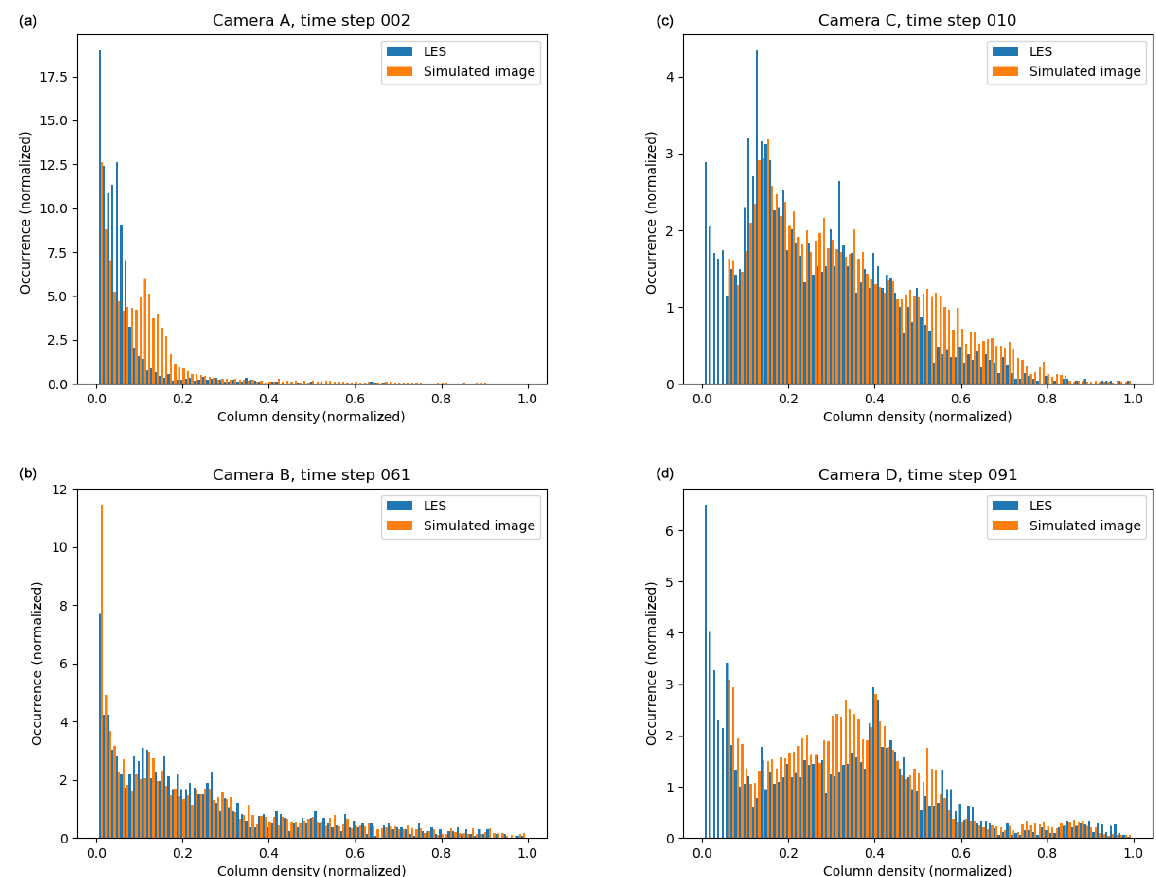
Figure 8. The probability density function (pdf) of the column densities from the LES and simulated images in Figs. 4–7.